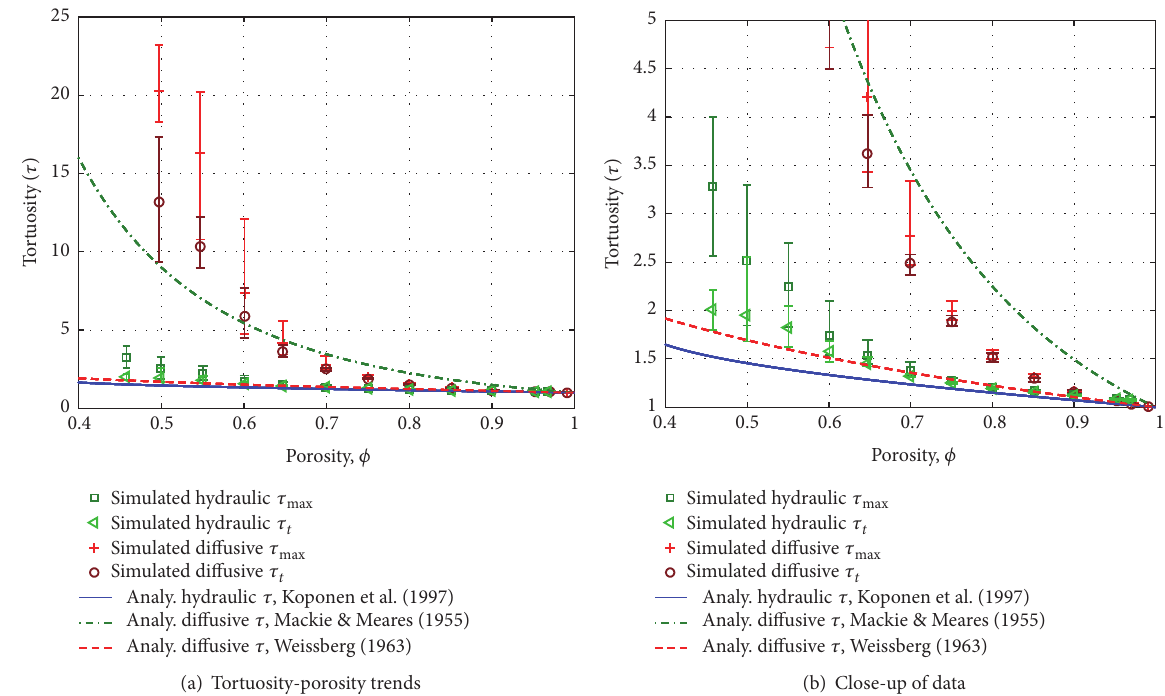
Figure 23: Comparison of hydraulic ( 𝜏 ℎ,𝑥 and 𝜏 ℎ,𝑦 ) and diffusive ( 𝜏 𝑑,𝑥𝑥 and 𝜏 𝑑,𝑦𝑦 ) tortuosity trends for pore structures of randomly distributed squares, against trends reported in